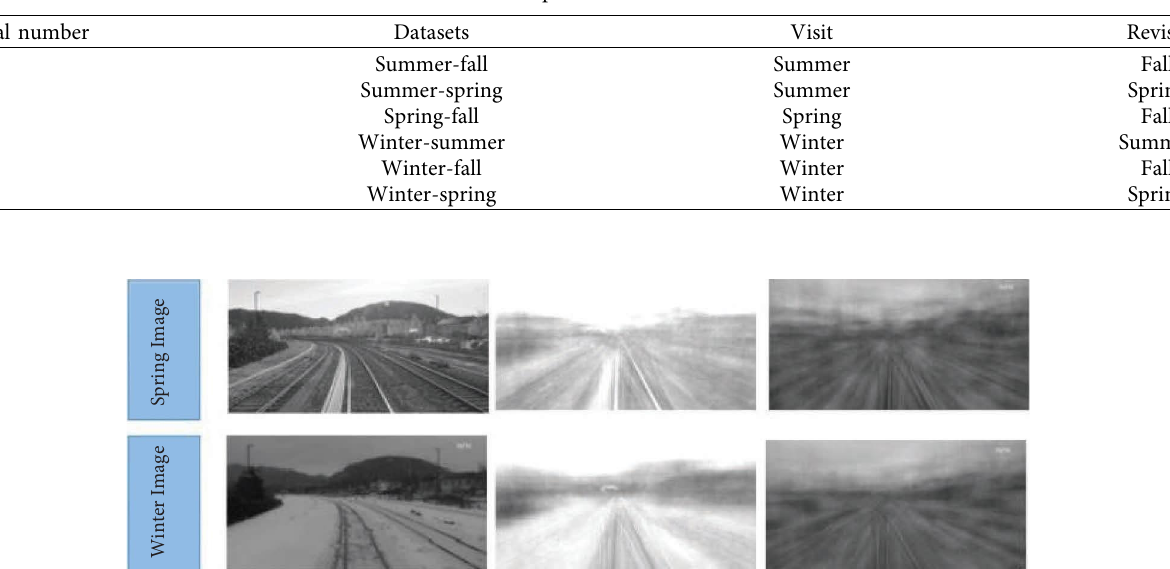
Figure 2: First column: two images from the same locations in two diferent seasons (Nordland dataset). Second column: images are projected on the frst 100 principal components (PCs). Tird column: images are projected on the second 100 main components (PCs); dependent features of the scenes are associated with the frst few principal